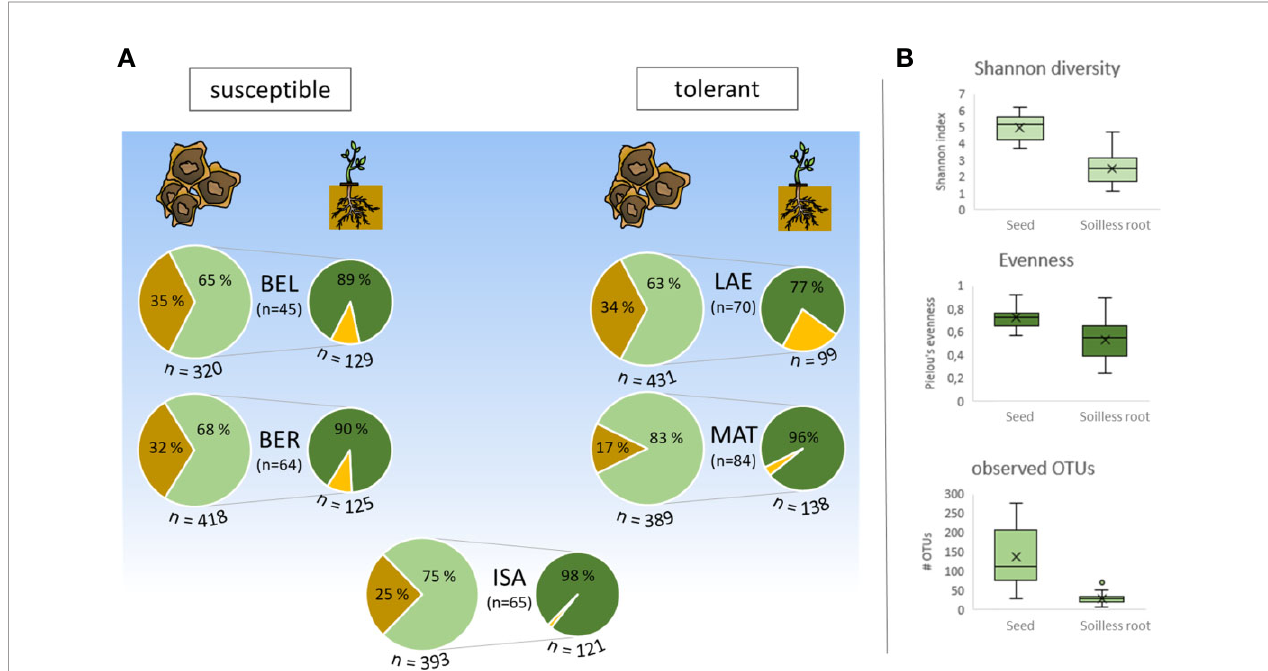
FIGURE 3 | Comparing seed and in vitro root microbial community on relative abundance of sequence variants (ASV). (A) fraction of surviving bacteria originating from seeds (left pie chart) in soilless seedlings (right pie chart). Percent values refer to mean relative abundance, while n stands for the number of involved ASVs (below pie charts: total number in microhabitat; between pie charts: number of shared ASVs); brown: unique in seeds; green: shared ASVs; yellow: unique in vitro root ASVs. (B) Differences in alpha diversity indices between seed and in vitro root